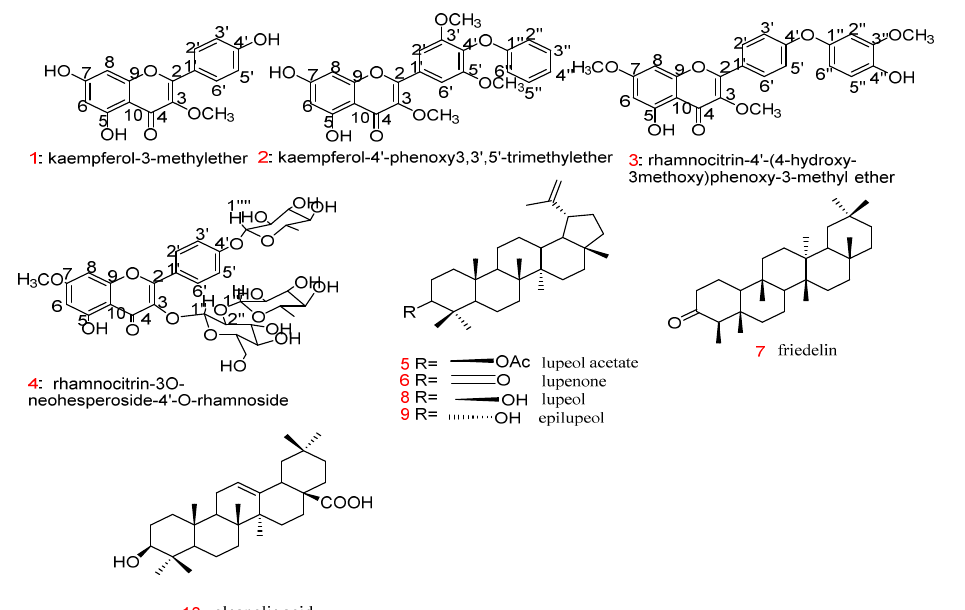
Figure 2. Structure of compounds 1 to 10 with anti-inflammatory effects. Table 1. The biological activities of isolated compounds from plants in the central and western re- gions of SA.